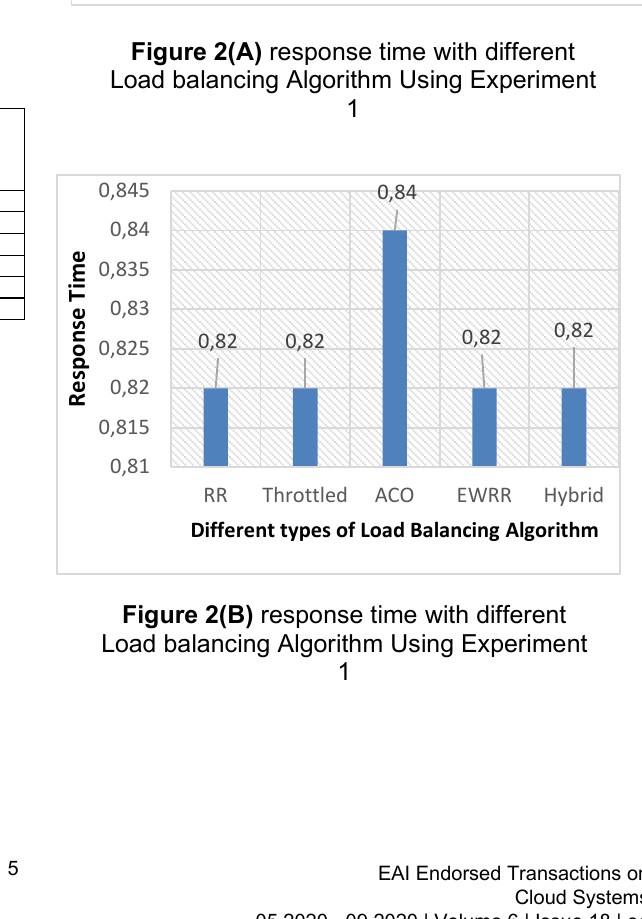
Different types of Load Balancing